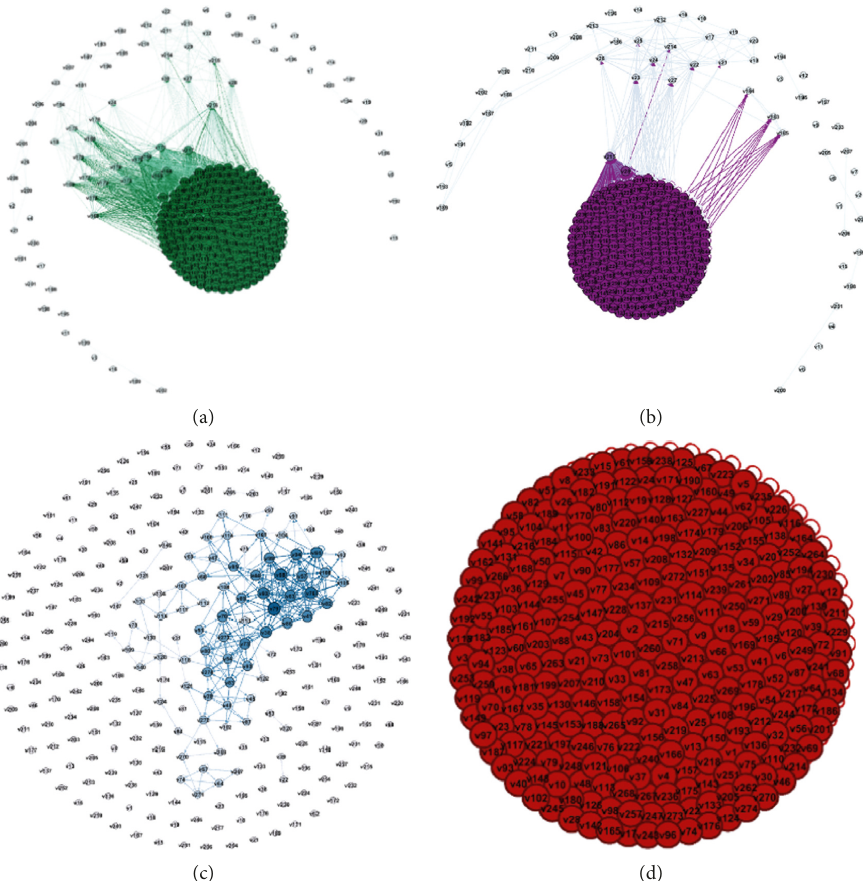
Figure 5: FCN model of rolling bearing’s different states. (a) FCN model of rolling element fault. (b) FCN model of inner ring fault. (c) FCN model of outer ring fault. (d) FCN model of normal state.